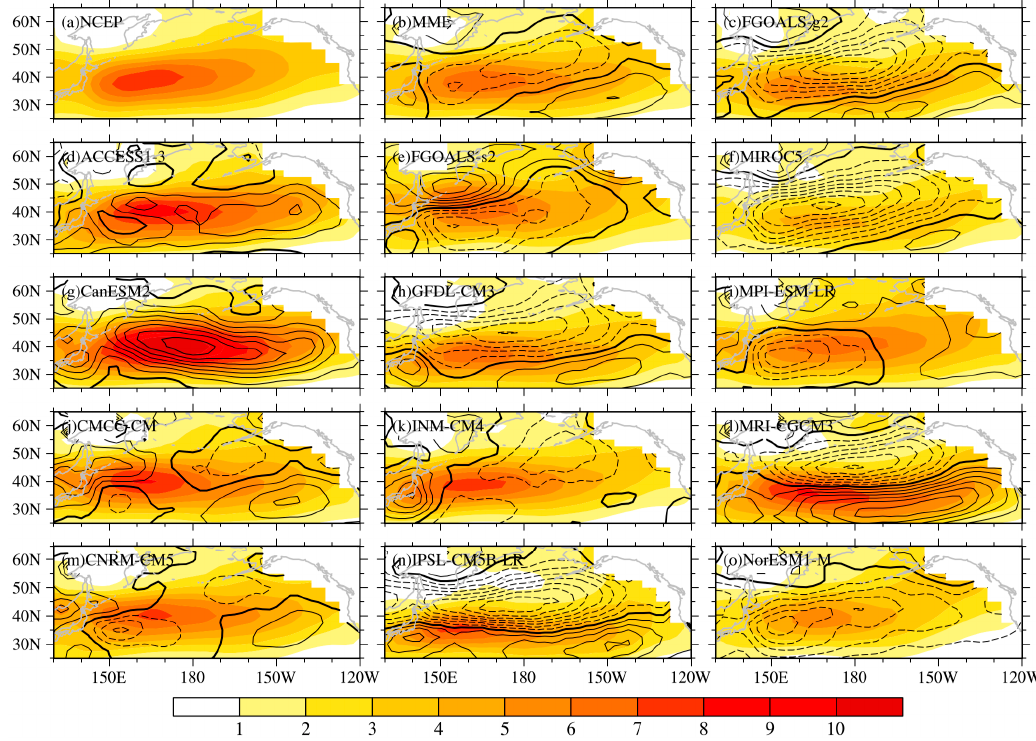
Figure 1. Winter North Pacific Storm Track (WNPST) climatology (Shading) and the difference between each model and NCEP reanalysis (contour, with an interval of 0.5, black bold line represents the contour with the zero value) (unit: K ∙ ms − 1 ). The value is not shown in blank areas to avoid data contamination by terrain effect.